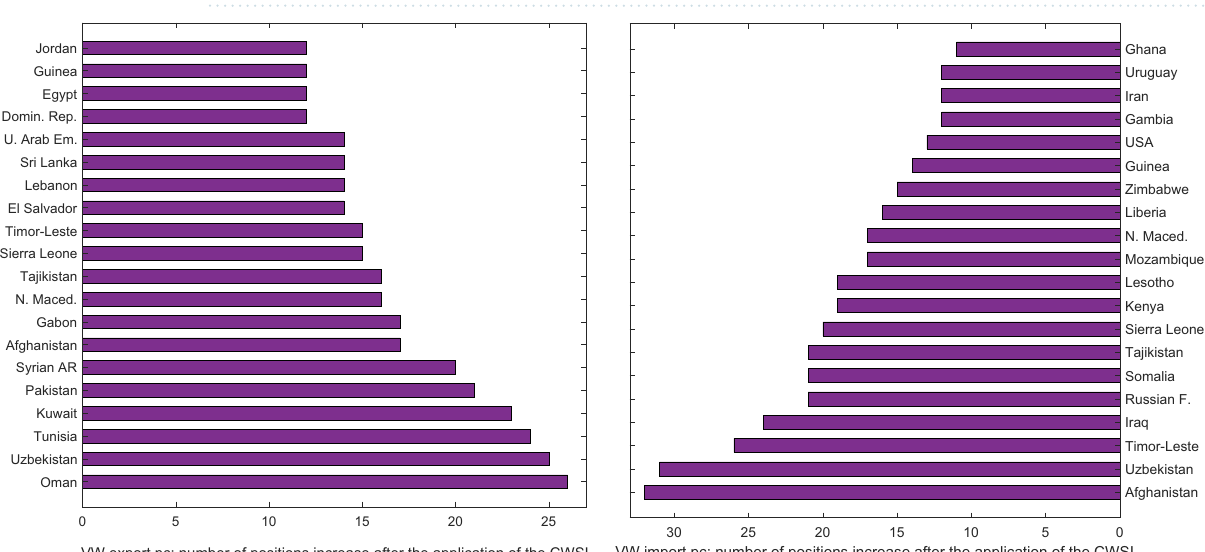
Figure 6. Left panel: 20 countries with the highest increase in position for VW export per capita if the CWSI is applied. Right panel: 20 countries with the highest increase in position for VW import per capita if the CWSI is applied. Rankings are on 149